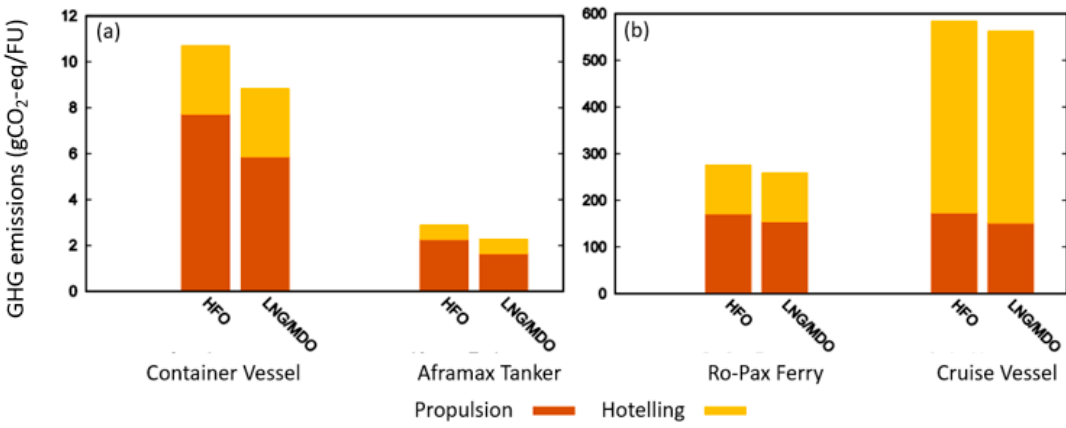
Figure 9. Contribution of Propulsion and Hoteling demands to the tank-to-propeller GHG emissions: ( a ) two-stroke-engines; ( b ) four-stroke-engines.